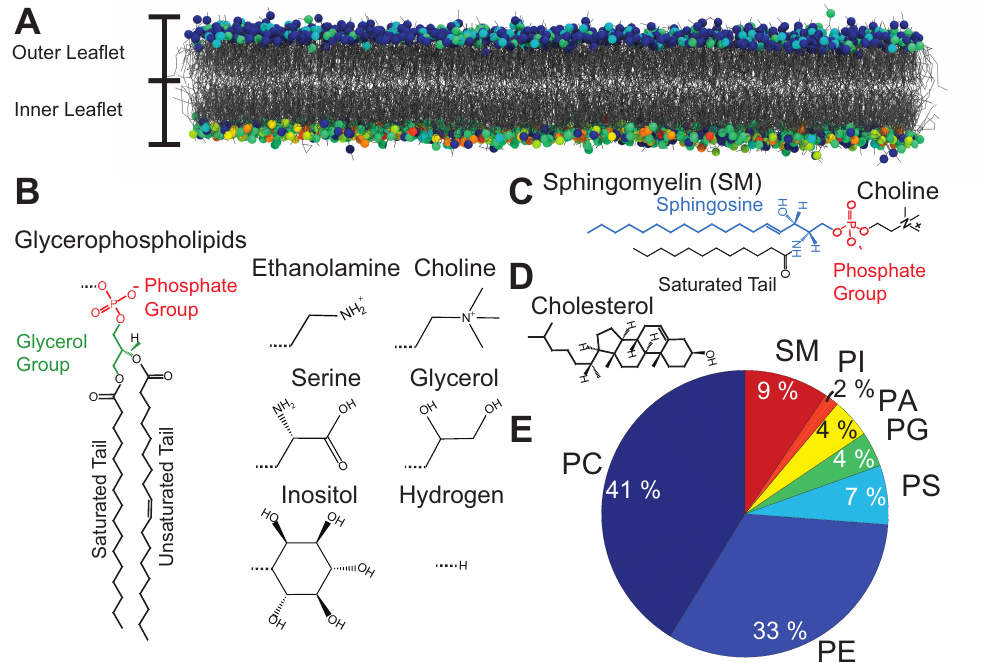
Figure 2. ( A ) A lipid membrane is formed by two layers (leaflets) of lipids molecules. Most mem- branes are built asymmetrically. ( B ) Glycerophospholipids and sphingomyelin consist of a hydrophilic head group and two hydrophobic tails. ( B – E ) Chemical structures of glycerophospholipids, sphin- gomyelin, and cholesterol. Common head groups are: choline, ethanolamine, serine, glycerol, inositol, and hydrogen. ( E ) Lipid distribution of the RBC cytoplasmic membrane. Figure adapted from [28]. PLs are built around a glycerol moiety. Two of the carbon atoms are esterified to (see Figure 2B) [29]. Common head groups include choline, ethanolamine, serine,